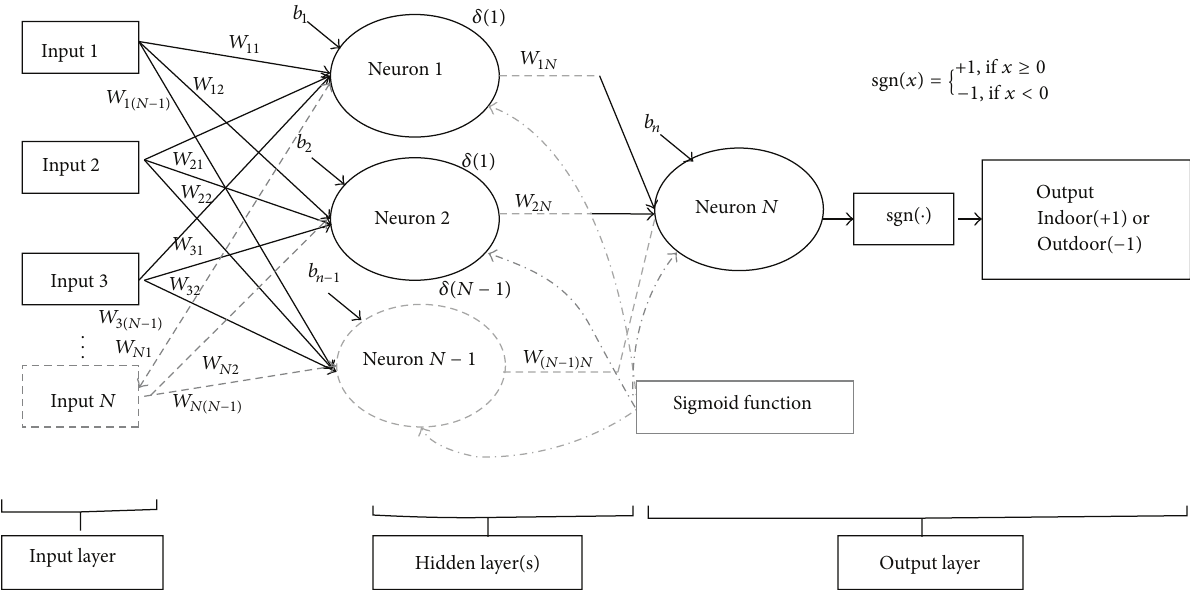
Figure 3: Structure of MLPFFBP in the proposed